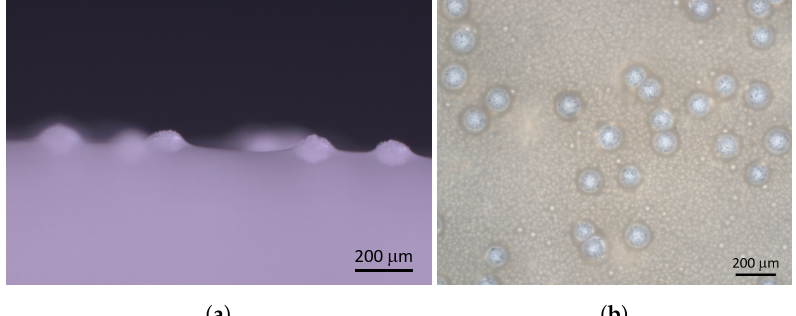
Figure 5. Optical microscopy images of the combined microcapsule-membrane structure manu- factured by the in situ approach. ( a ) Side view of microcapsules embedded in the top layer of the membrane surface. ( b ) Top view of randomly distributed single microcapsules.